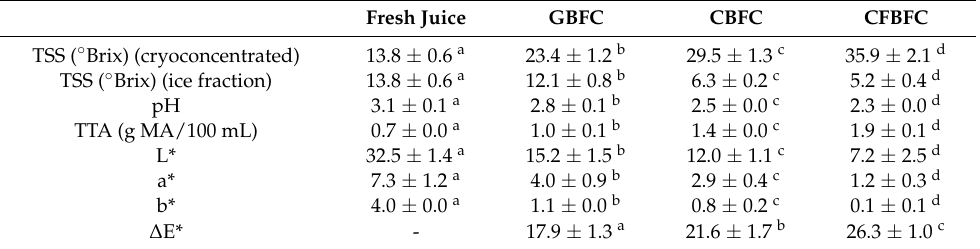
Table 1. Physicochemical characteristics of fresh juice, cryoconcentrated and ice fractions. Fresh Juice GBFC CBFC CFBFC TSS ( ◦ Brix)